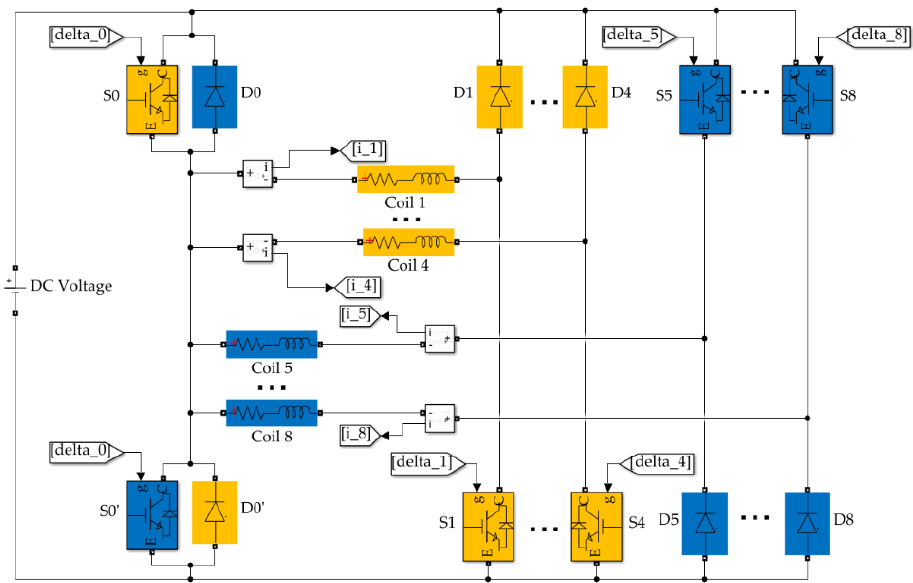
Figure 14. Current control loop with a neutralized-sharing-bridge SPA (with controller omitted).